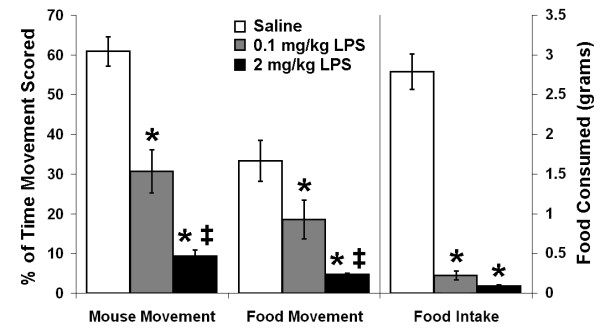
Activity and feeding behavior during the first scotophase after LPS injection. Digital video images were scored for activity and mouse induced movement of food pellets during the first scotophase after injection of saline (open bars), 0.1 mg/kg LPS (shaded bars) or 2 mg/kg LPS (black bars) and compared to the total amount of food consumed during the same 12-hour period. Movement data are presented as the percent of the total frames that movement was scored (left axis). Food intake in grams is presented on the right axis. Values are mean ± SEM (n = 5 for saline and 2 mg/kg LPS groups, n = 6 for 0.1 mg/kg group). * P < 0.03 vs. corresponding saline control. ‡ P < 0.05 vs. corresponding 0.1 mg/kg LPS dose.